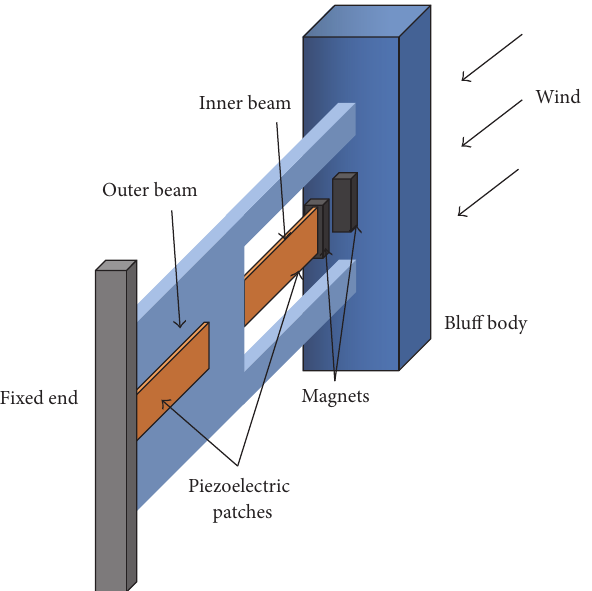
Figure 2: Schematic of 2DOF piezoelectric galloping energy har- vester for power enhancement at low wind